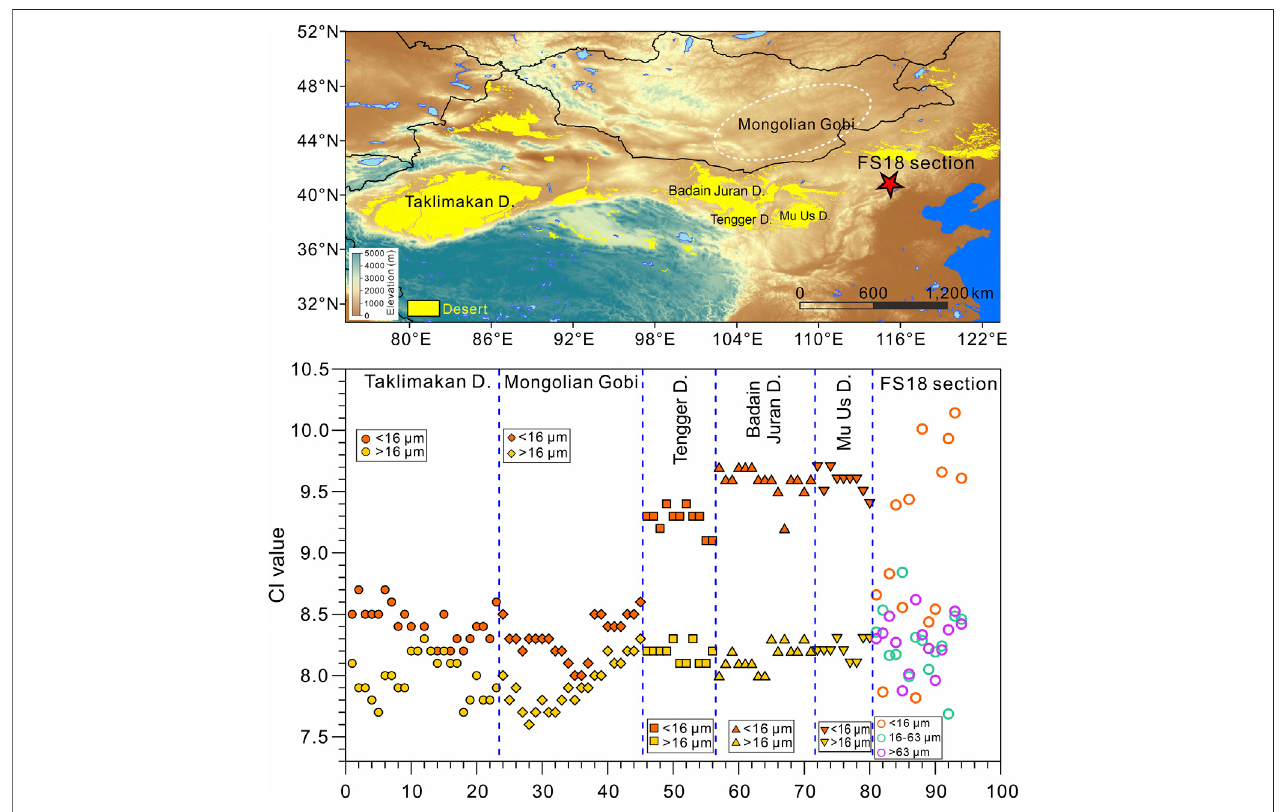
FIGURE 7 | Upper panel: locations of the involved sites. Lower panel: crystallinity indices of quartz for < 16 μ m and > 16 μ m fractions from the fi ve deserts in North and Northwest China (Sun et al., 2013), and for < 16 μ m, 16 – 63 μ m and > 63 μ m fractions from the FS18 loess.